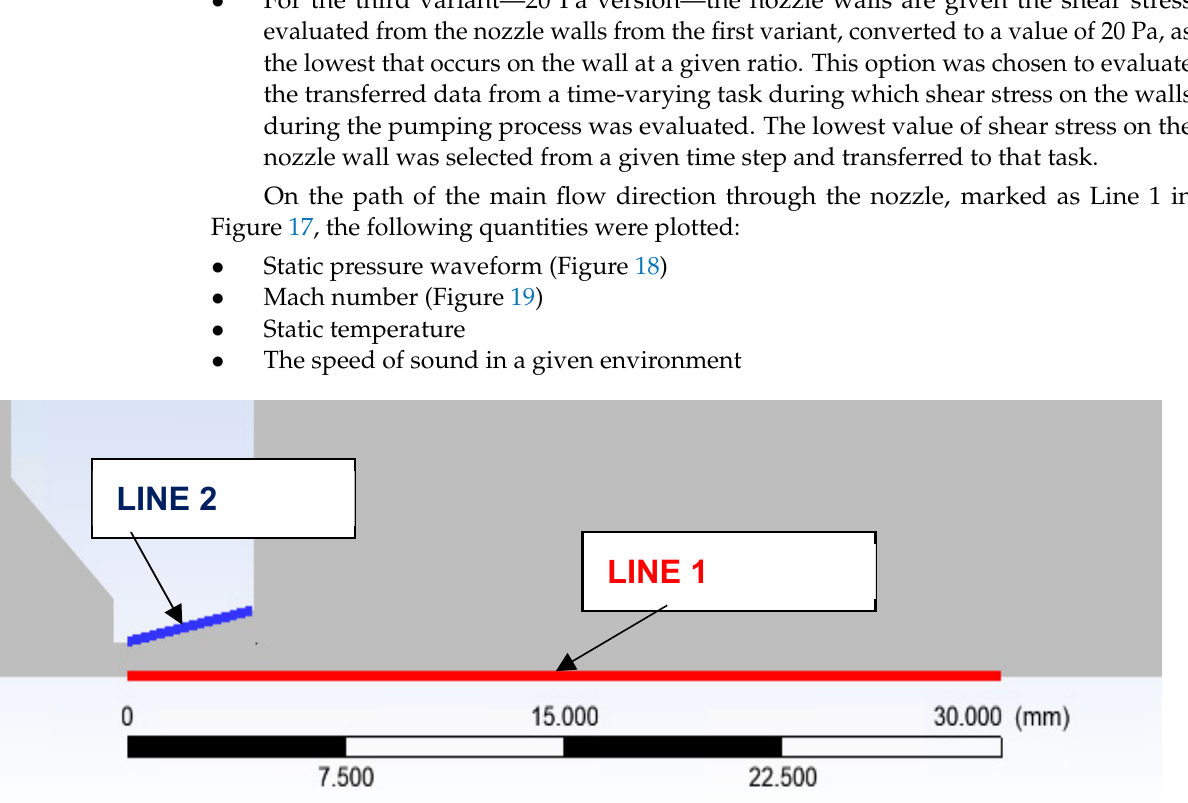
Figure 17. Selected paths for plotting results.